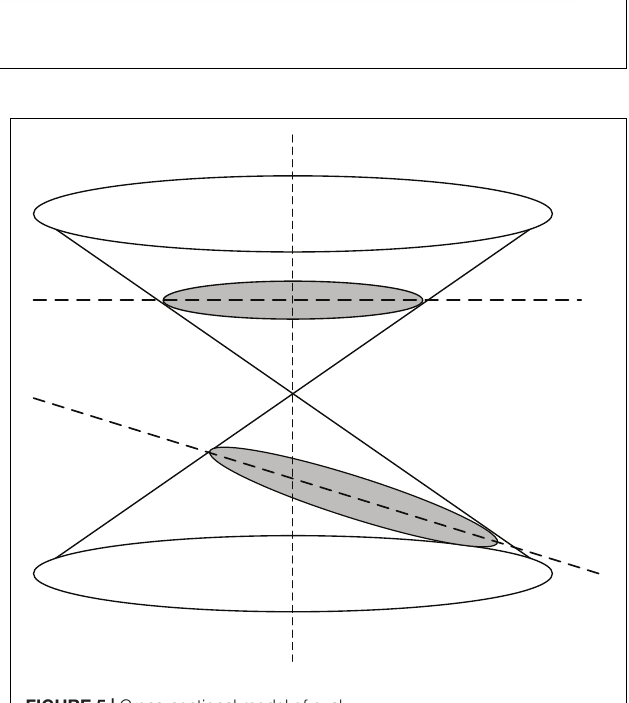
FIGURE 5 | Cross-sectional model of